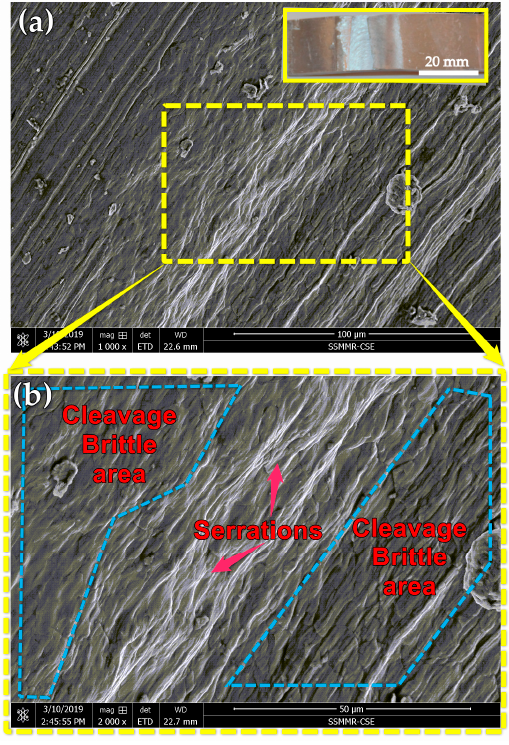
Figure 23. ( a ) The fracture morphology of the BT-FSW lap joint welded at a travel speed of 1000 mm/min and rotational speed of 600 rpm using Sq pin and ( b ) at a higher magnification.